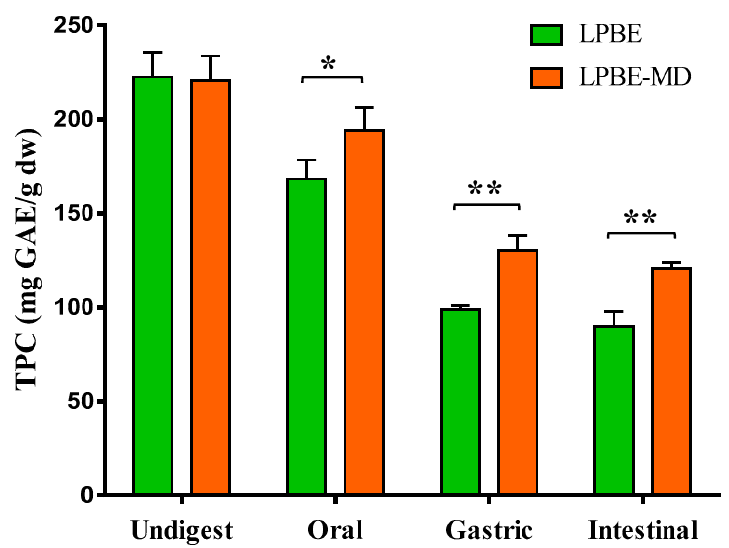
Figure 2. Total phenolic content (TPC, mg GAE/g dw) and bioaccessibility (%) of non-encapsulated (LPBE) and encapsulated (LPBE-MD) PBE before and after gastrointestinal digestion. Values are expressed as mean ± SD of three experiments. * p < 0.05, ** p < 0.01.